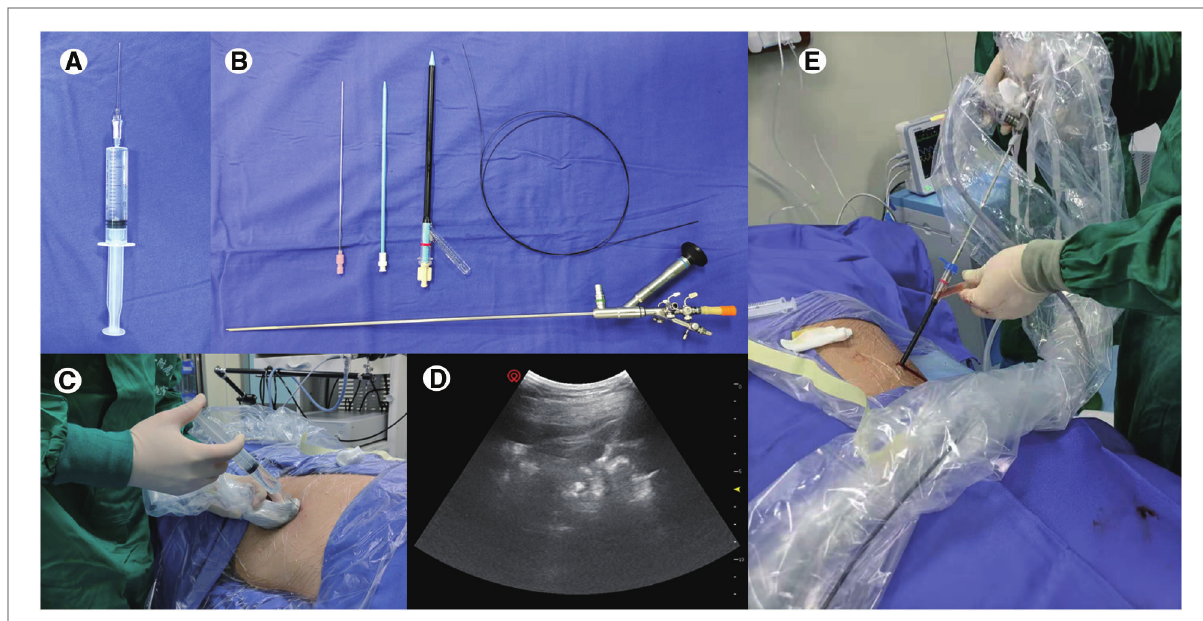
FIGURE 1 Main instruments and operation procedures of percutaneous nephrolithotomy for modi fi ed local anesthesia. ( A ) 1% lidocaine 10 ml and ropivacaine hydrochloride 10 ml were mixed for local injection, and a 20GA 1.88IN venous indwelling needle [Singapore Becton Dickinson Medical (S) Pte Limited] with a 20 ml syringe was used for drug injection. ( B ) An 18-gauge needle was used for percutaneous punctures, a 12F or 14F fascial dilator was applied for dilation, and an ureteroscope (8/9.8F) was for laser lithotripsy. ( C,D ). The injection of anesthetic was along the percutaneous nephrolithotomy channel under ultrasonic guidance. ( E ) An 18F or 20F ClearPetra Nephrostomy Sheath was used for the establishment of a percutaneous renal channel; the lateral channel of the sheath connected with negative suction ensures intrapelvic low pressure and stone fragments were easy to fl ush